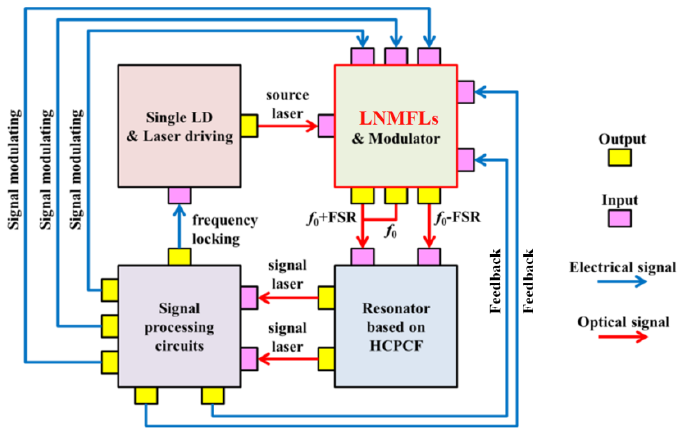
Figure 1. Topological structure of the HC-RFOG.